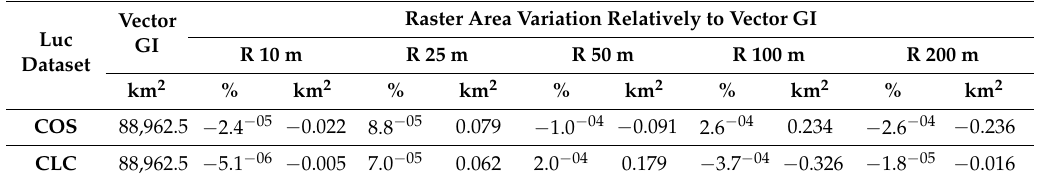
Table 3. Area of mainland Portugal in vector GI and area variation after vector-to-raster conversion. Luc